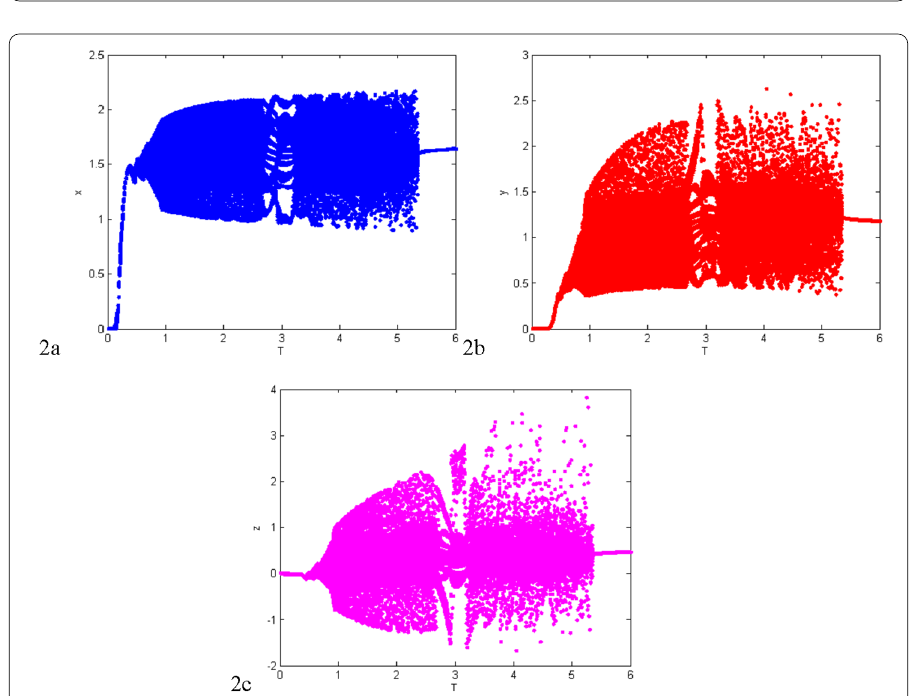
Figure 2 Bifurcation diagrams of system (1.2) with x (0) = 0.5, y (0) = 0.9, z (0) = 0.7. The system exhibits stable solution, periodic doubling bifurcation, and chaotic phenomenon corresponding with different T . ( a ) is the bifurcation diagram of population x ( t ). ( b ) is the bifurcation diagram of population y ( t ). ( c ) is the bifurcation diagram of population z ( t